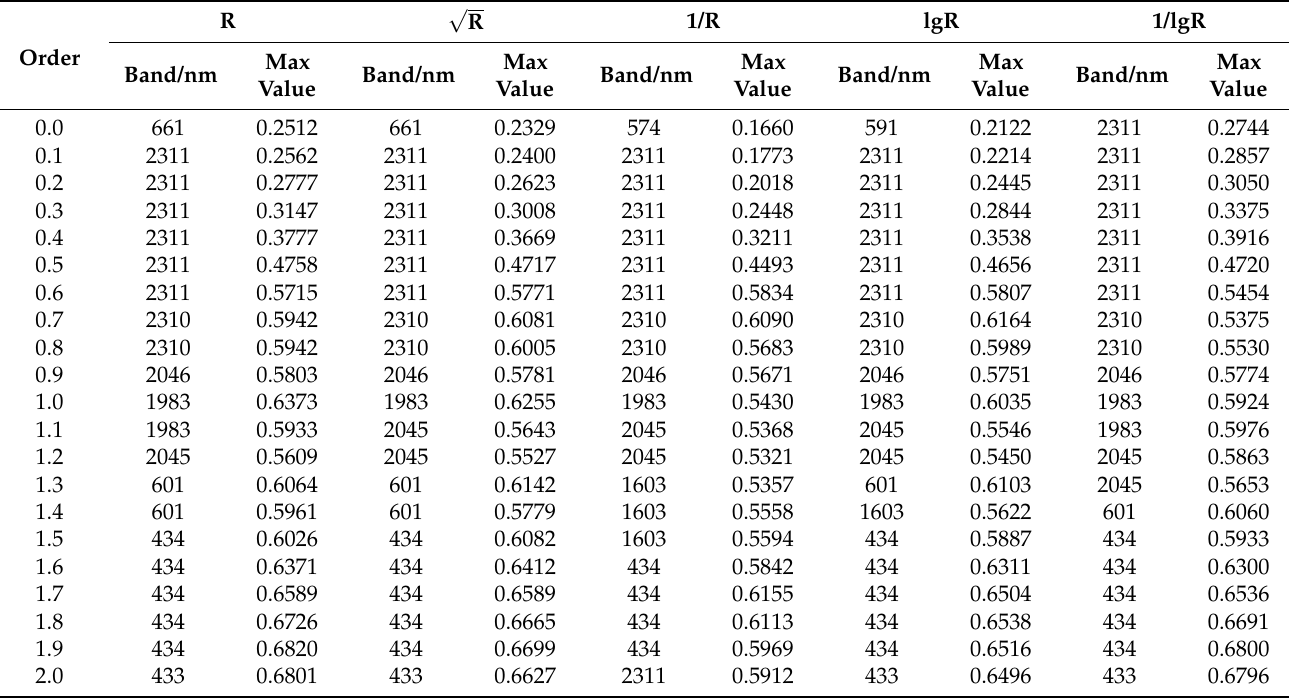
Table 5. The absolute value of the maximum correlation coefficient between the hyperspectral and Na + in Area B and its corresponding band.